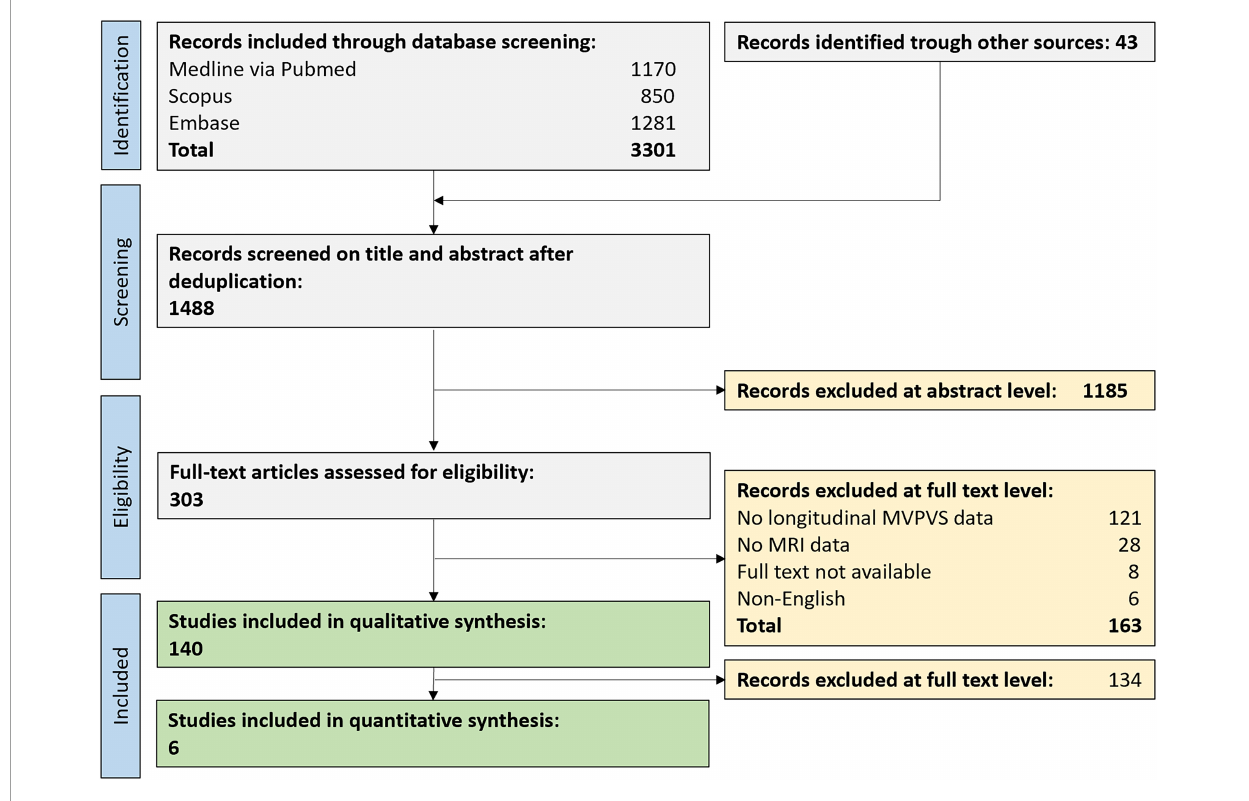
FIGURE2 Flow chart of study inclusion. MVPVS, MRI-visible perivascular